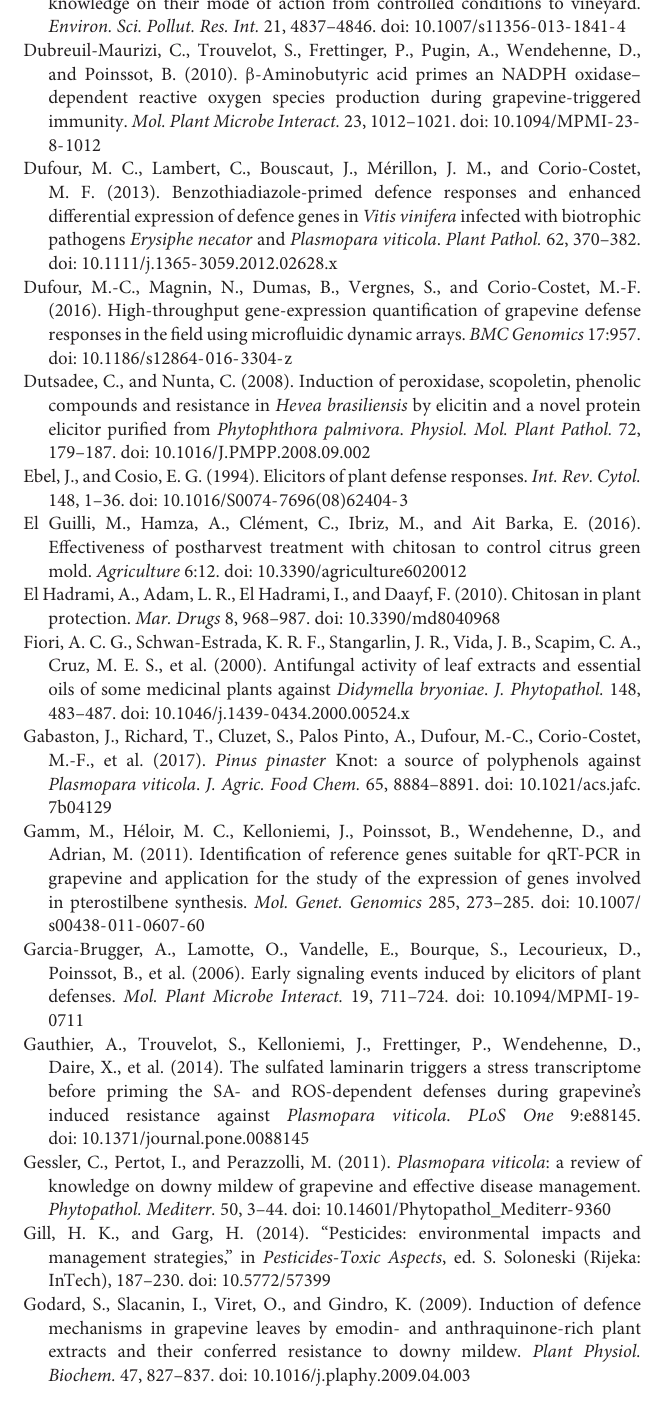
TABLE S1 | Sequences of the primers used for qRT-PCR